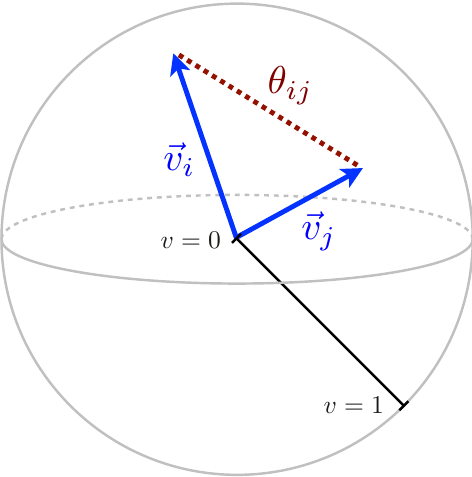
Figure 11 . The space of (massive) particle kinematics, with pairwise distances corresponding to Euclidean distances in this space. Massless particles with v = 1 live on the boundary and particles at rest with v = 0 are at the origin. One can interpret this (cid:12)gure as a snapshot of the event taken at a time t after the collision, when the particles have traveled a distance vt